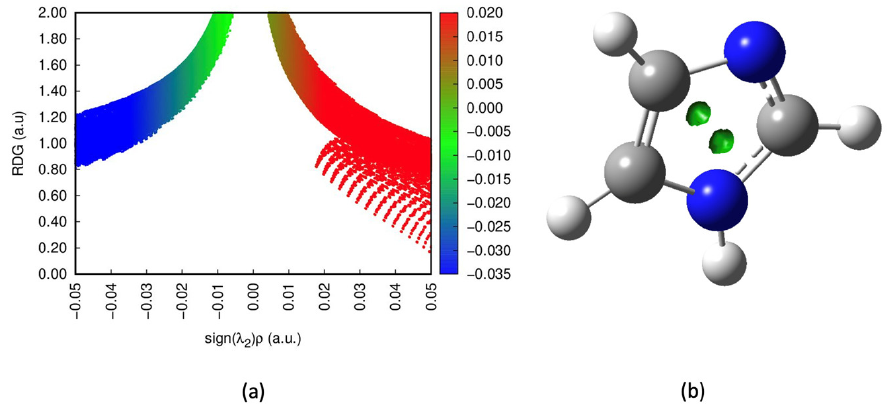
Figure 4. Color-coded legend explaining the significance of sign ( λ 2 ) ρ to help interpret the scatter graph .